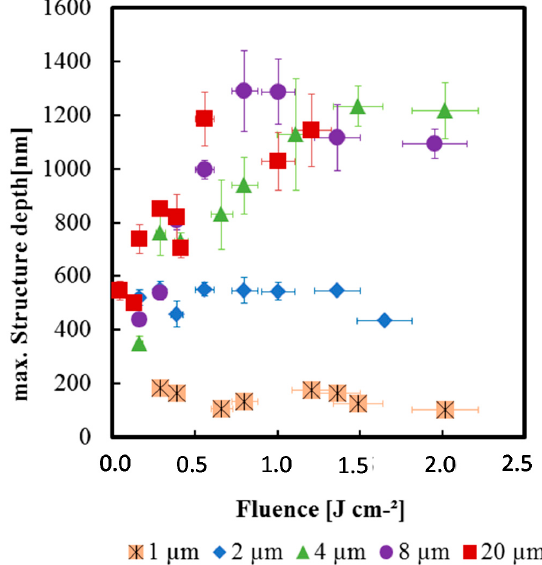
Figure 3. Exemplary dependence on maximum structure depth and fluence for line-like structures at PC (266 nm, 10 ns) with different periods.